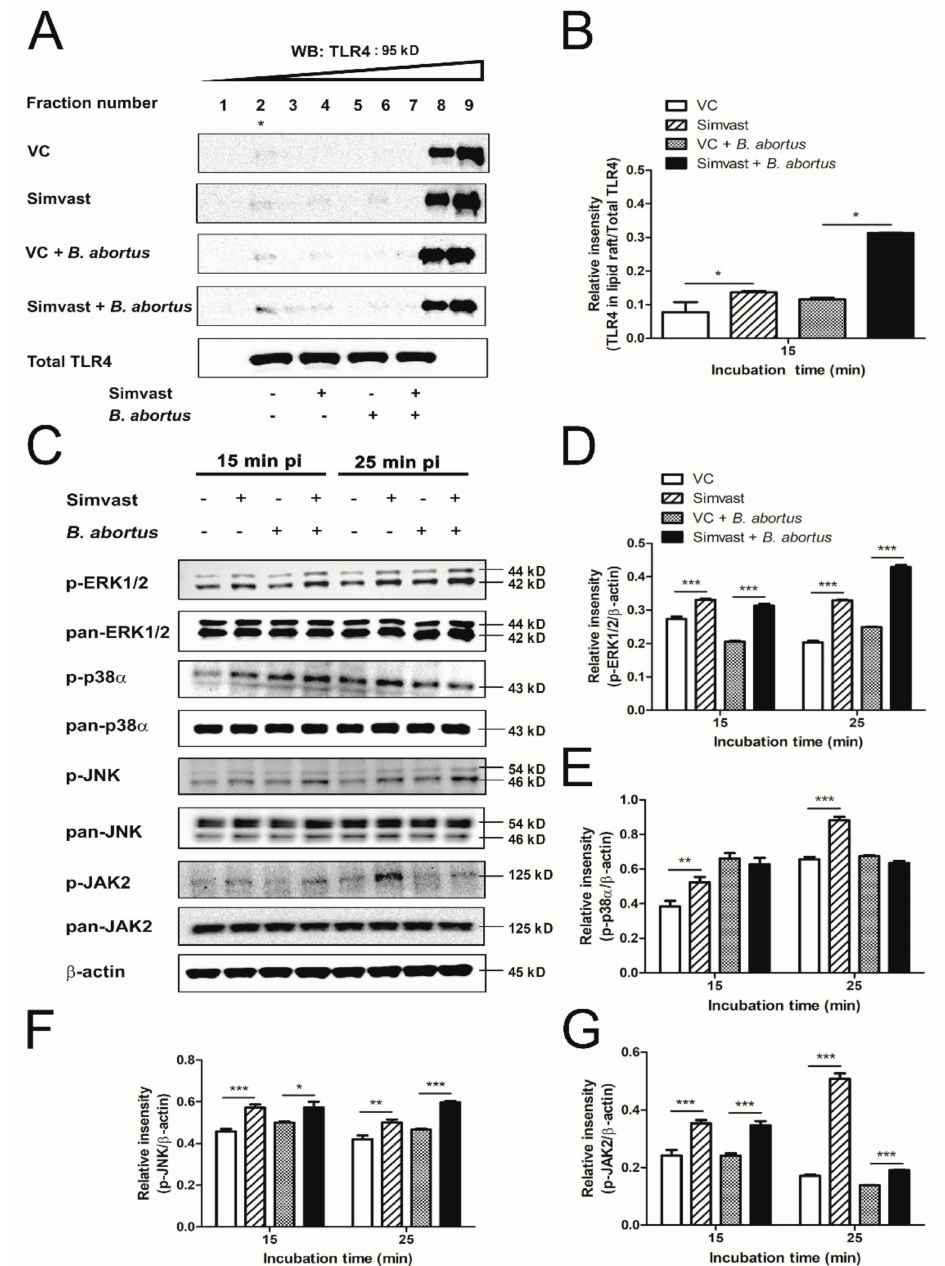
Figure 2. The effect of simvastatin on the activation of signaling pathway upon B. abortus infection at 15 and 25 min pi. Cells were pre-treated with 20 µ g/mL of simvastatin. At 15 min pi, lipid raft isolation was performed, and the distribution of TLR4 in lipid raft was analyzed using immunoblotting assay ( A ). The lipid raft fractions are indicated by an asterisk in fraction 2, WB: Western blot. ImageJ software was used to calculate the relative intensity of TLR4 in lipid raft compared to total cellular TLR4 ( B ). The downstream signaling pathway of TLR4, including MAPKs (ERK1/2, p38 α , and JNK) and JAK2 was also analyzed by immunoblotting assay at 15 and 25 min pi ( C ), and the relative intensity of these proteins normalized to the control β -actin was carried out by ImageJ software ( D – G ). The data are represented as the mean ± SD of duplicate samples from at least two independent experiments. Statistically significant differences relative to control group are indicated by an asterisk (* p < 0.05, ** p < 0.01, *** p <